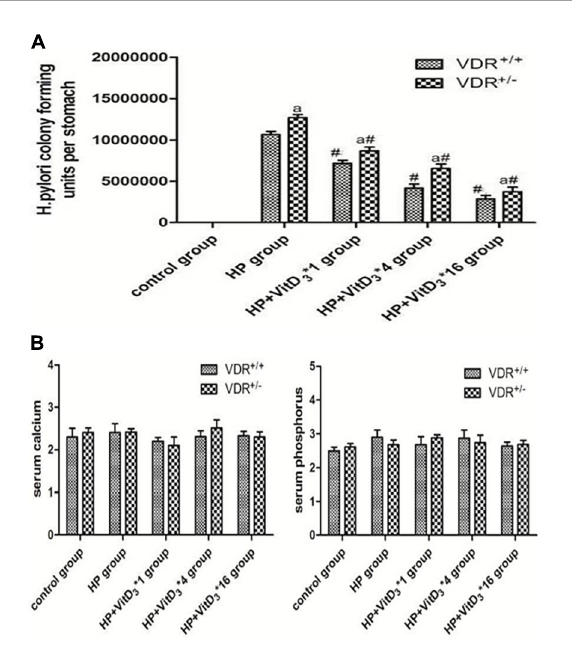
FIGURE4 Helicobacter pylori eradication efficacy of VitD 3 at different doses in infected mice. (A) Colony-forming assay results showing increased susceptibility of VDR + / − mice to H. pylori colonization compared to VDR + / + mice ( P < 0.05). In both mouse strains, H. pylori colonization was significantly reduced after VitD 3 administration and H. pylori numbers decreased in